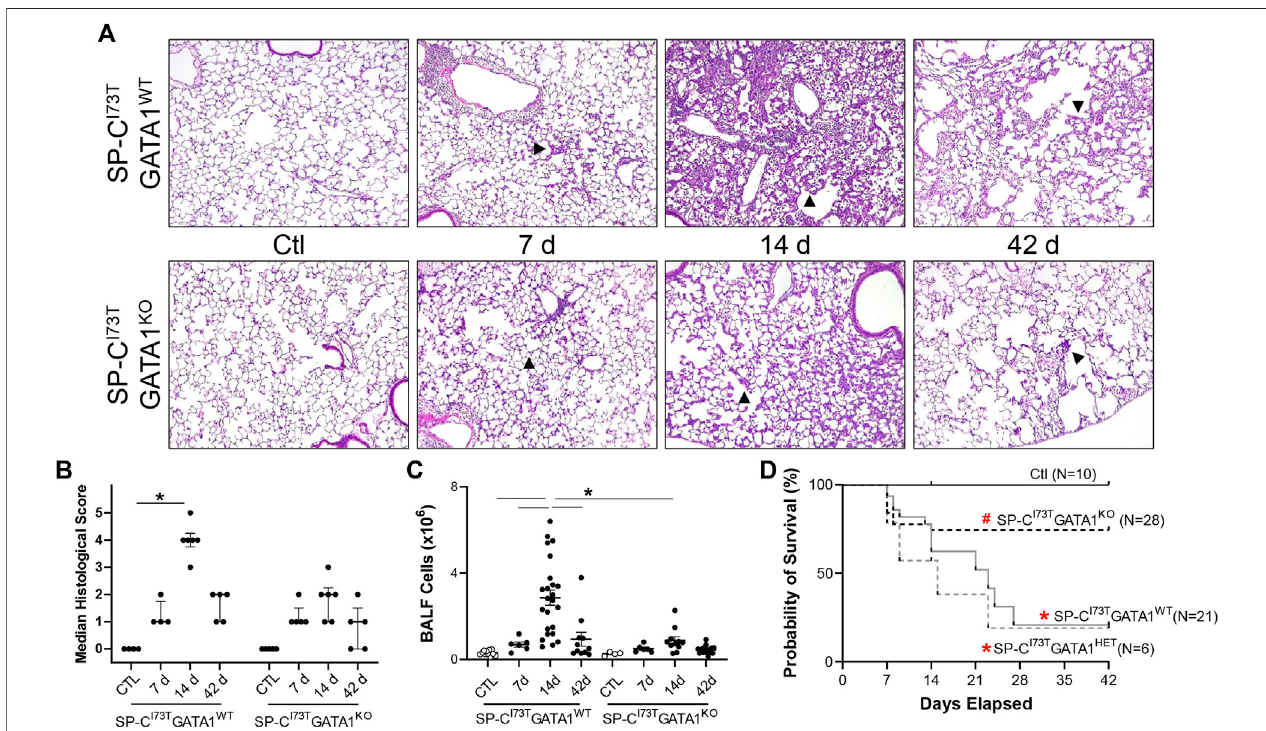
FIGURE 3 | Effects ofgenetic eosinophil lineage ablation on lung injury, survival and in fl ammation following SP-C I73T mutant induced injury. (A,B) Hematoxylin and Eosin stain and histological score of tissue sections from oil treated controls (Ctl), or tamoxifen treated SP-C I73T GATA1 WT and SP-C I73T GATA1 KO mice at 7 days, 14 days, or 42 days post injury. Arrowheads represent regions of interest, including septal remodeling edema, and cell in fi ltrate. Original magni fi cation: ×100. Representative images from at least 3 mice/group are shown. Scoring, shown as Median ± interquartile range, was based on weighted examination of tissue remodeling, in fl ammation, size and number of foci of injury. (C) Bronchoalveolar lavage fl uid (BALF) cell counts from oil treated controls (Ctl), or tamoxifen treated SP- C I73T GATA1 WT ,SP-C I73T GATA1 HET ,andSP-C I73T GATA1 KO miceat7 days,14 days,or42 dayspostinjury.Dataarepresentedasmean±SEM( n =4 – 23mice/group), analyzedusingtwo-wayANOVA.A p < 0.05(*)wasconsideredsigni fi cant.Linesmarksigni fi cantgroups. (D) Kaplan – Meiersurvivalanalysisfromoiltreatedcontrols(Ctl), or tamoxifen treated SP-C I73T GATA1 WT , SP-C I73T GATA1 HET , and SP-C I73T GATA1 KO mice up to 42 days post injury. Analysis include mice found dead or displaying body weight loss equating > 20% of experiment initiation. * p < 0.05 compared to control mice; # p < 0.05 compared to SP-C I73T GATA1 WT and SP-C I73T GATA1 HET mice by Log-Sum (Mantel-Cox) Rank